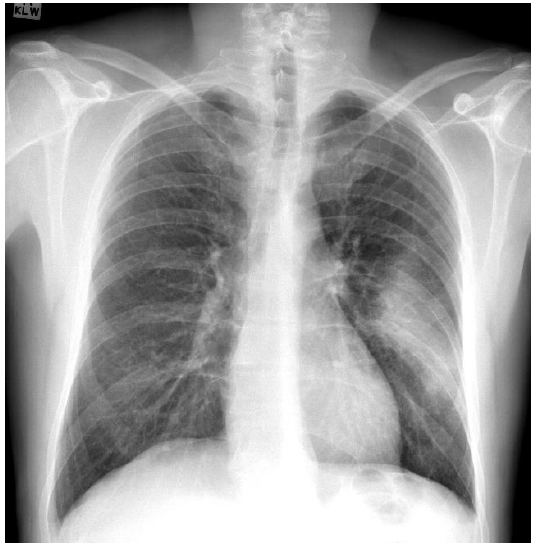
Figure 5. Chest radiograph example from the University of Montreal COVID-19 dataset marked by radiologists.